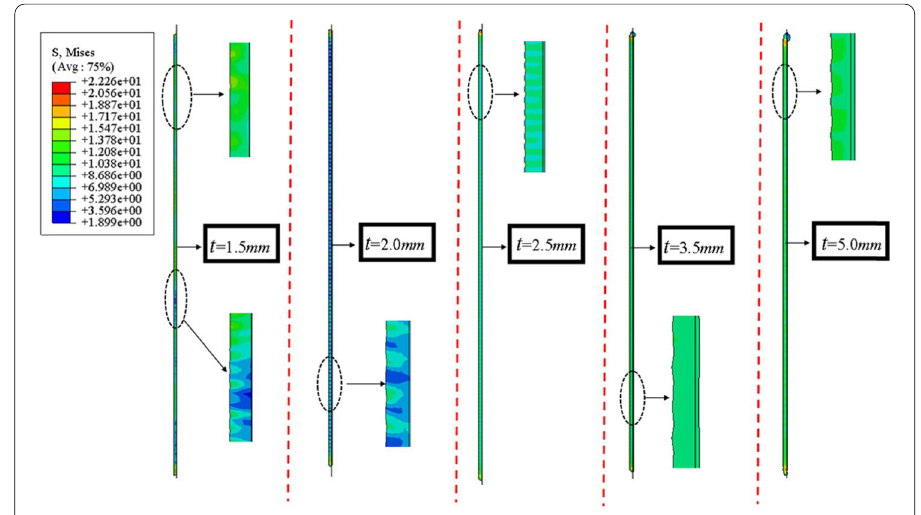
Fig. 10 The equivalent stress diagram of rubber cylinder with different wall thickness under pressure